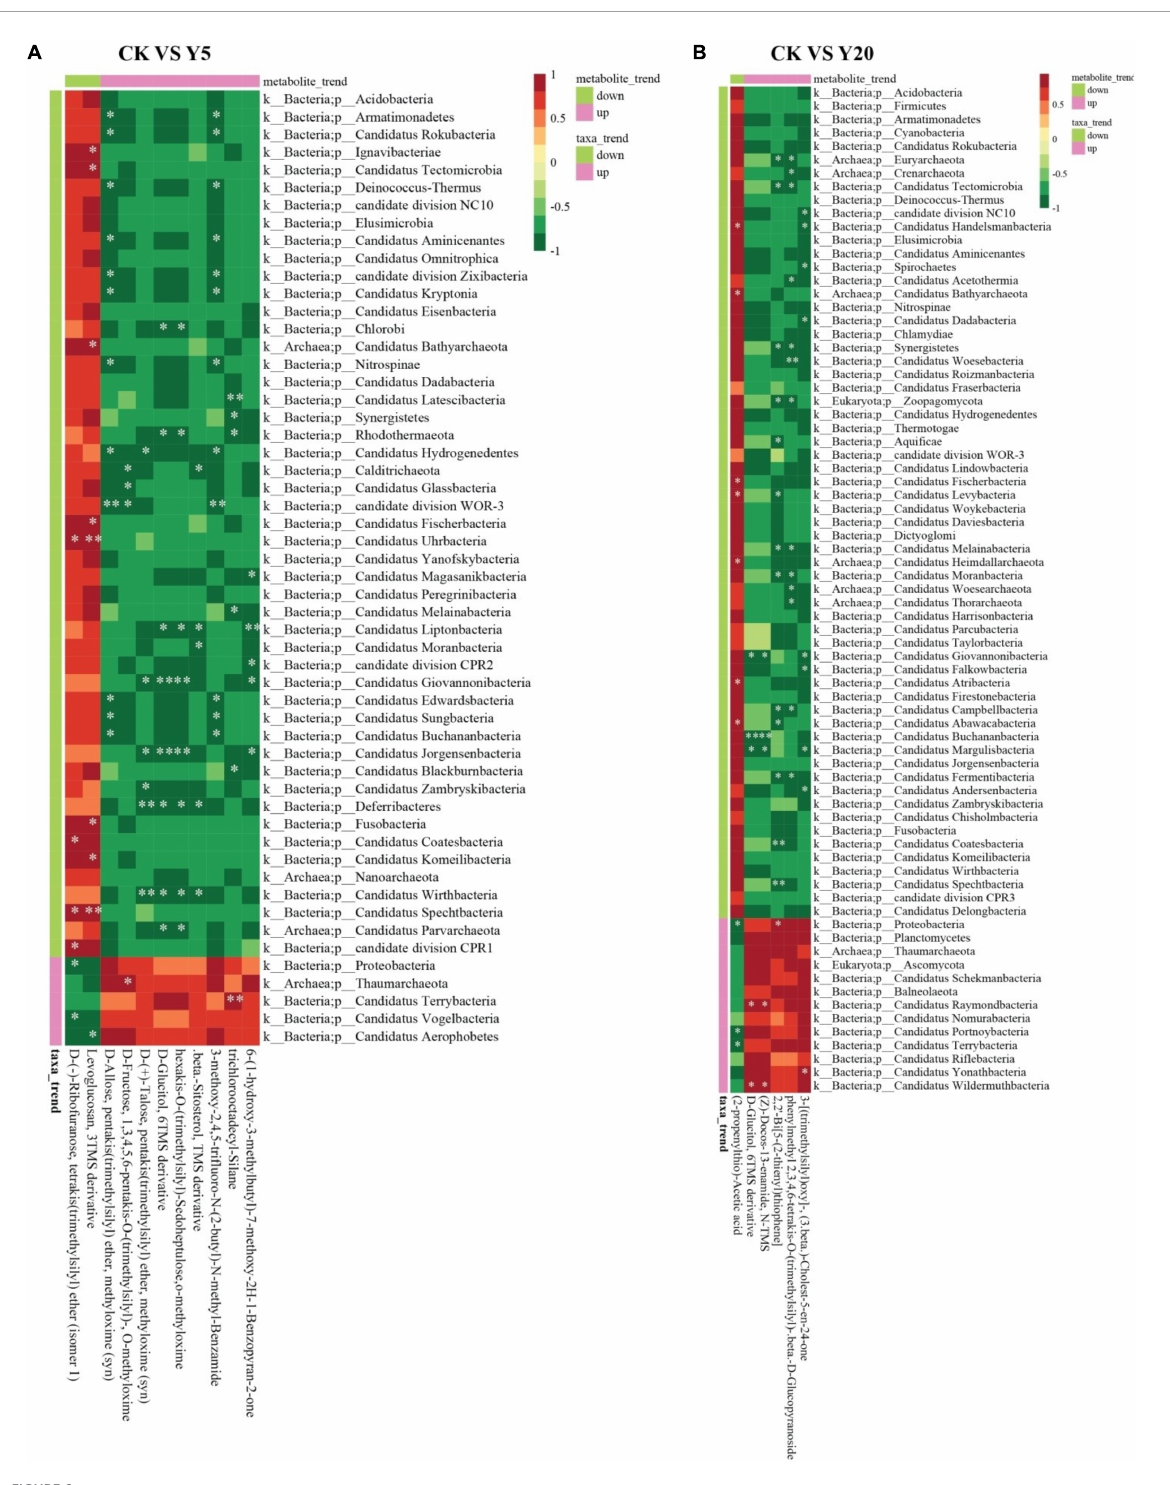
FIGURE6 Spearman’s correlation between abundant bacterial genera and significant metabolites for CK vs. Y5 (A) and CK vs. Y20 (B) . The horizontal bottom is the observed metabolite information, the horizontal top is the metabolite trend (upregulated or downregulated), the vertical right is the bacterial genera information, the vertical left is the taxa trend information, and the corresponding value of the intermediate heat map is the Spearman correlation coefficient r (range = –1 to +1); r < 0 is a negative correlation, r > 0 is a positive correlation, and the * indicates the significance at a p -value < 0.05 and ** indicates the significance at a p -value <